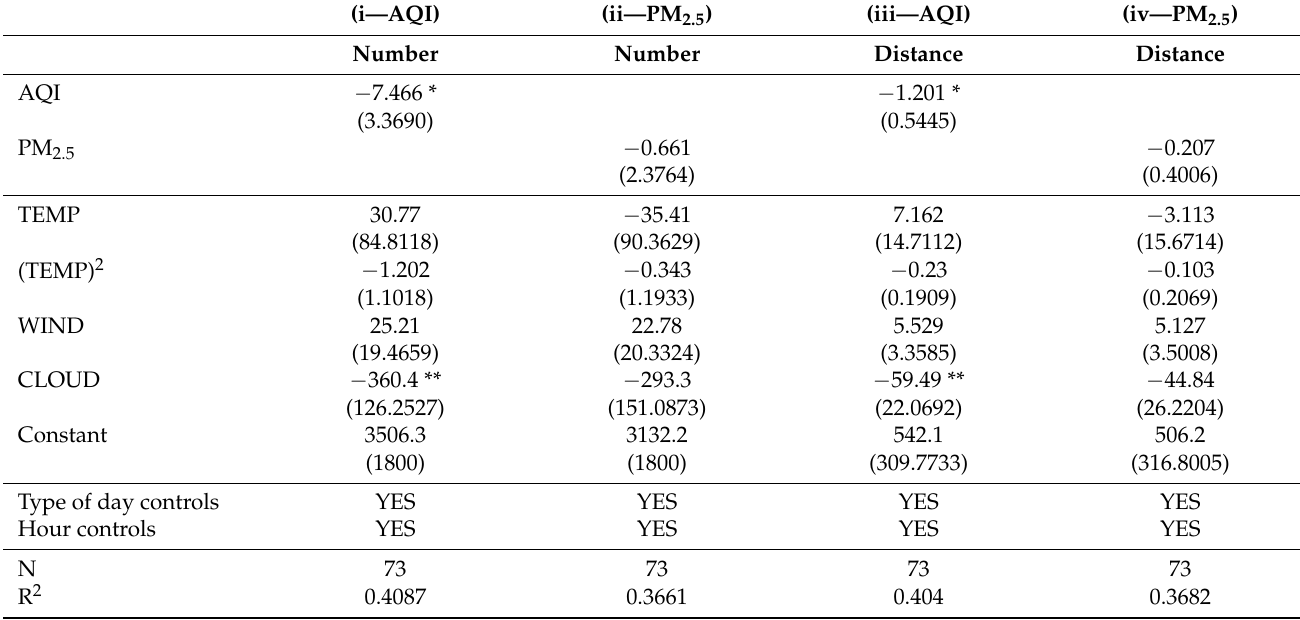
Table A18. Estimations of the effects of air pollution on people walking.